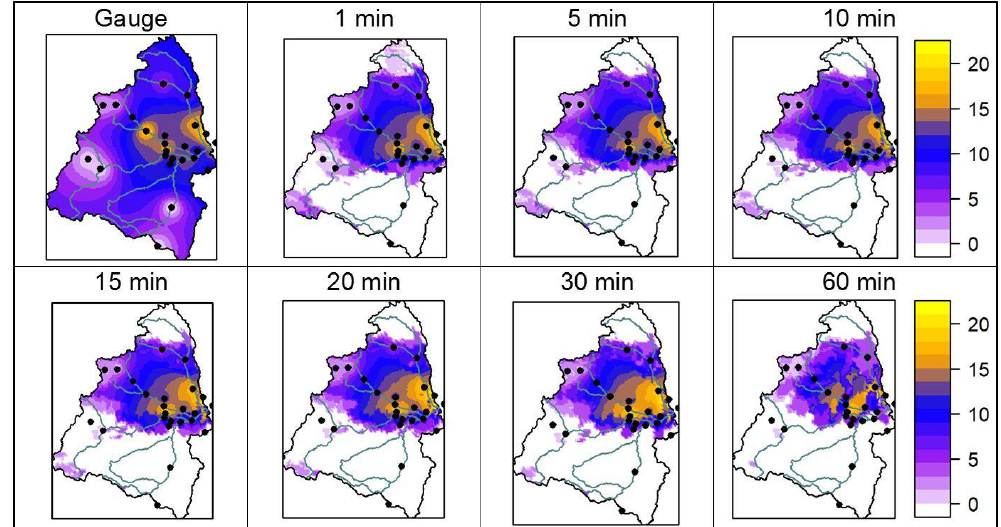
Figure 12. Accumulated rainfall (mm) for the event on 04/17/2015. Rain spatial distribution for the basin using only rain gauge network data (upper left) and radar data for different sampling times with 0.5-km spatial resolution.